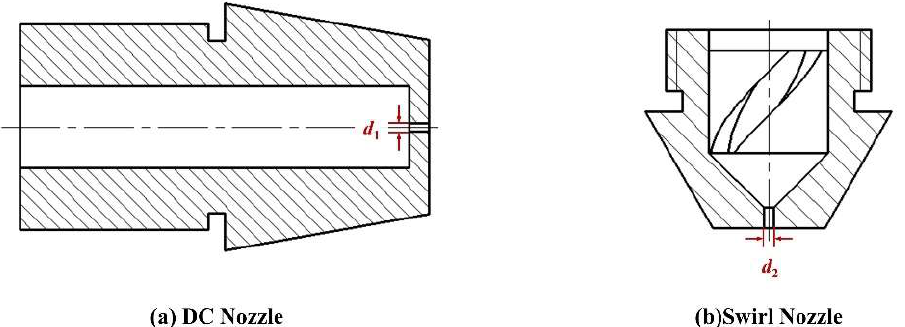
Figure 3. Structure of the DC nozzle and swirl nozzle. The self-excited oscillation nozzle is an improved single-phase atomization nozzle, which introduced a resonant chamber in the nozzle. The resonant chamber generates self- excited oscillations at a specific frequency to excite the destabilization of the jet, which could enhance the atomization of liquid fuel. Jia et al. [19] showed that self-excited oscillation nozzles are ideal atomizers for nanoparticle suspensions, while, in this paper, we tested the atomization performance of the self-excited nozzle when using the gelled fuels containing nanoparticles. This nozzle has four key parameters: oscillation chamber inlet diameter d 1 , resonant chamber diameter D , resonant chamber length L , and nozzle outlet diameter d 2